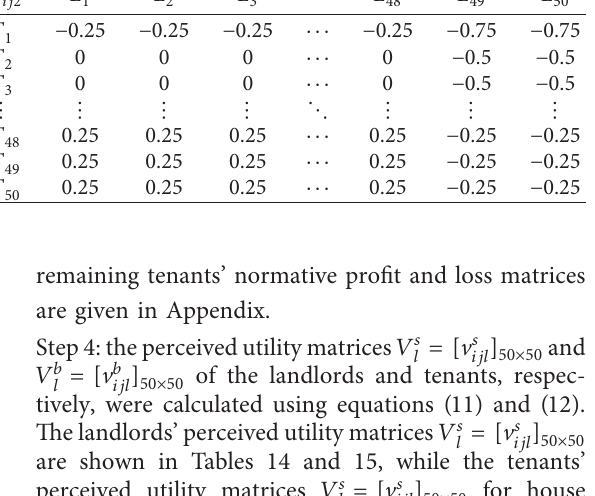
� [ v b ] for tenants’ ij 2 50 × 50 2